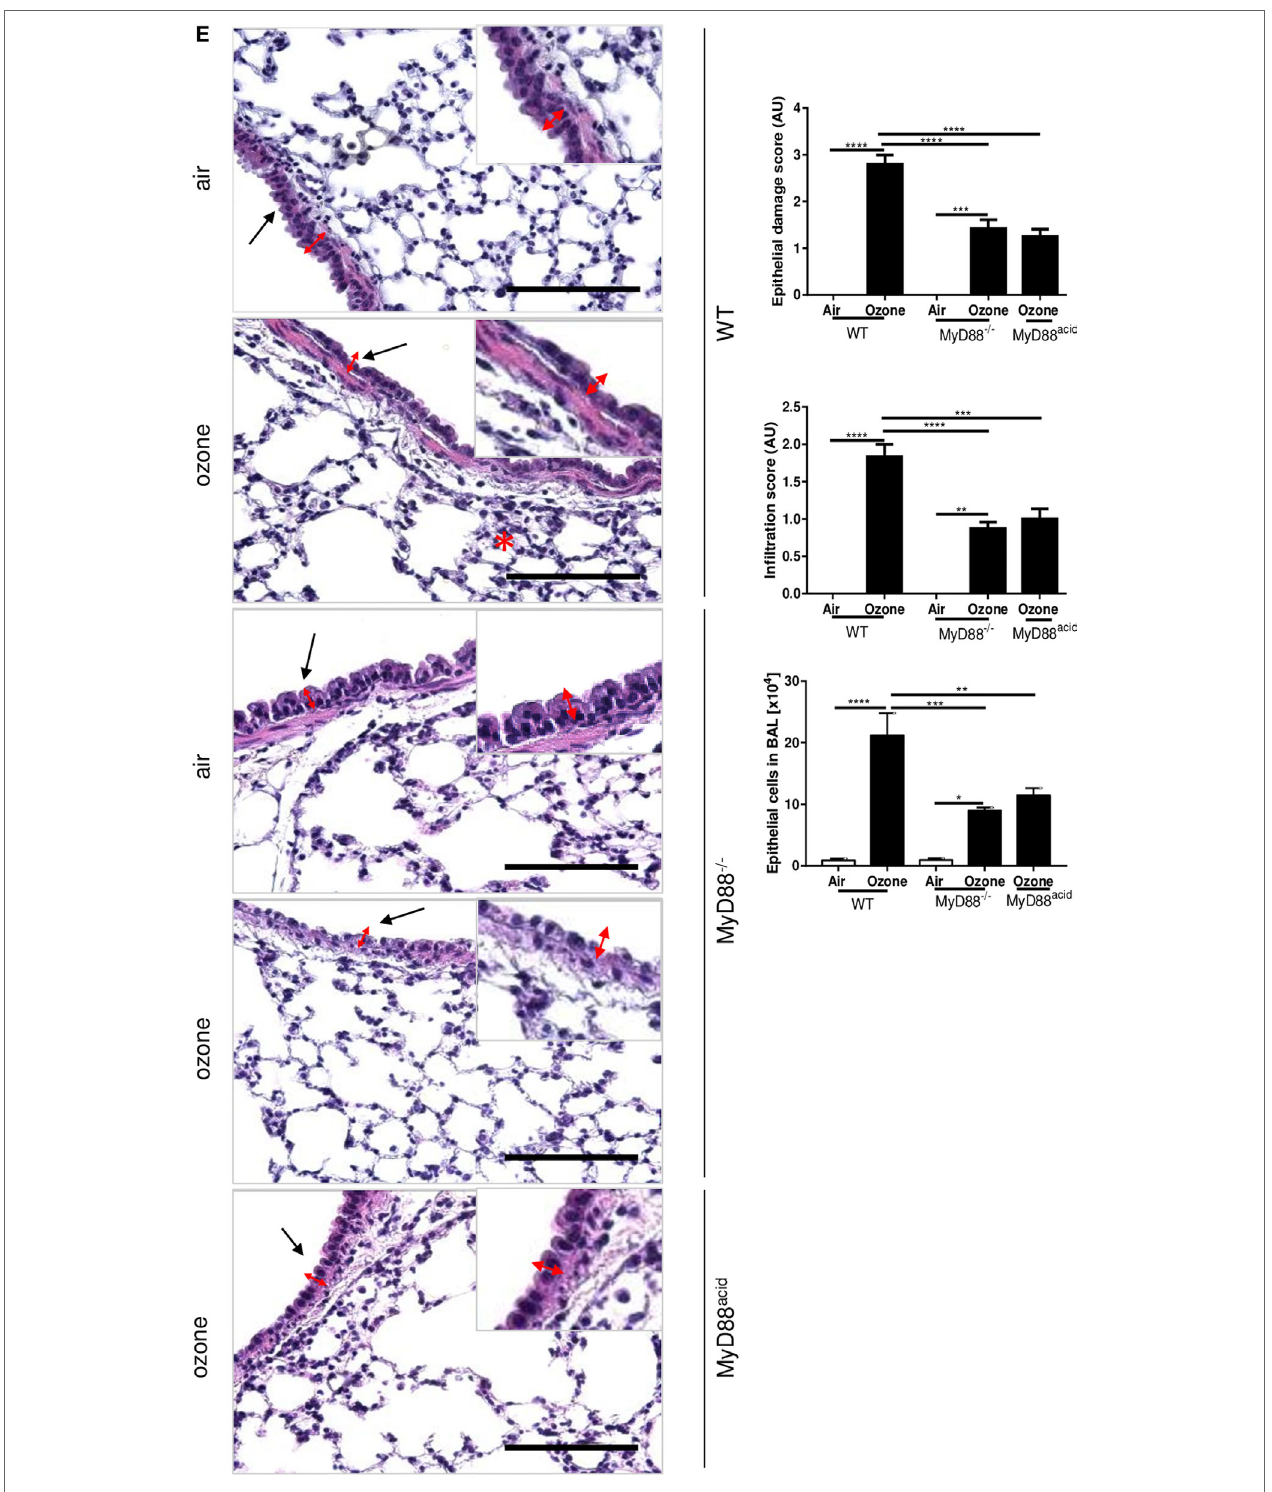
FigUre 4 | The myeloid differentiation factor-88 (MyD88) pathway in epithelial cell is involved in inflammation induced by ozone. Total cell number (a) , neutrophil counts and myeloperoxidase (B) , protein and lipocalin-2 (c) , tissue remodeling parameters, matrix metalloproteinase 9, and tissue inhibitor metalloproteinase 1 (D) , and histology, scale bar = 100 µm (e) are shown in wild type, MyD88 − / − and MyD88 acid mice, 24 h after ozone exposure. Representative data from two- independent experiments are given. Results are expressed as mean ± SEM and are from one experiment, with n = 5–6. Statistical test: ordinary one-way ANOVA, with Bonferroni post test, p value: **** < 0.0001, *** < 0.001, ** < 0.01, * <